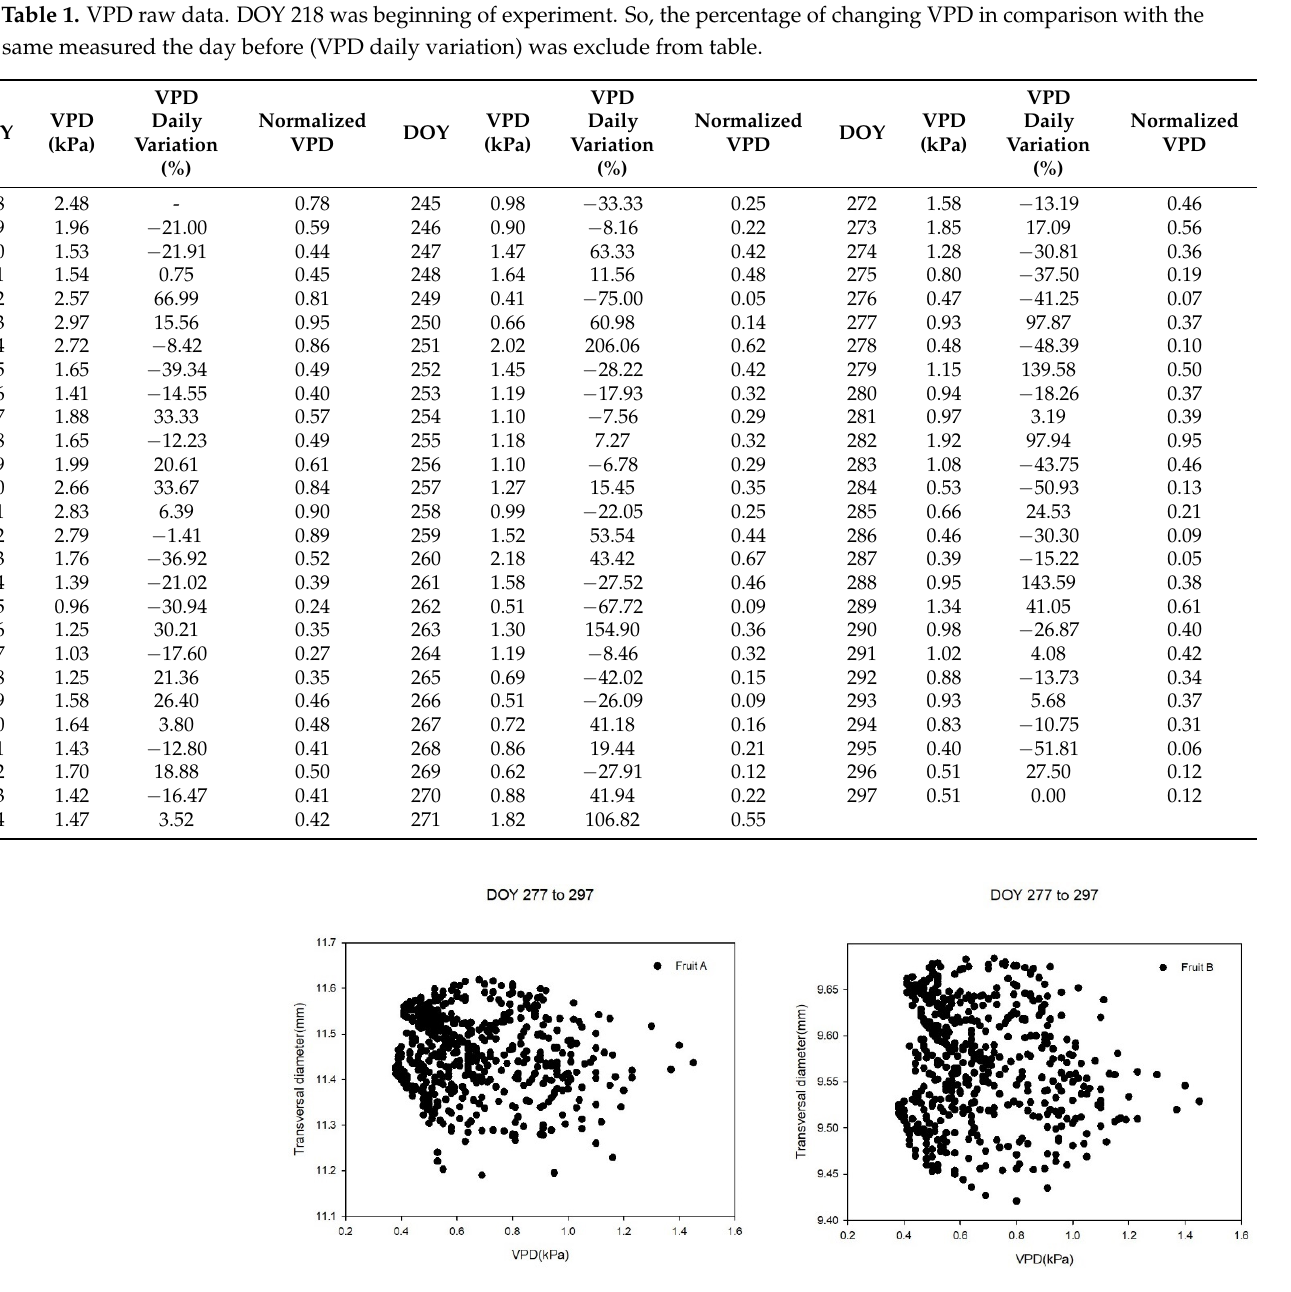
0.55 The correlation coefficients of fruit A diameter versus VPD at the first and second period of the experiment were − 0.527 and − 0.286 and for fruit B were − 0.453 and − 0.232. The data showed moderate negative relationships between VPD and fruit diameter at the first period of the experiment and very weak negative relationships at the second period of the experiment. Furthermore, correlation data for the first part (DOY 218–252) and the second part (DOY 253–276) of the first period of the experiment were − 0.608 and − 0.377 for fruit A and − 0.541 and − 0.256 for fruit B, showing that correlations between fruit